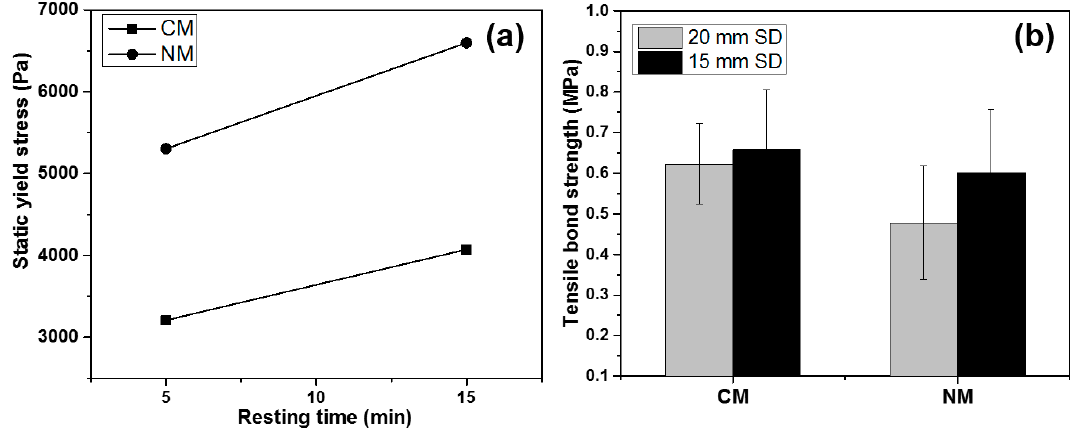
Figure 5. ( a ) static yield stress; ( b ) tensile bond strengths of CM and NM mixtures.